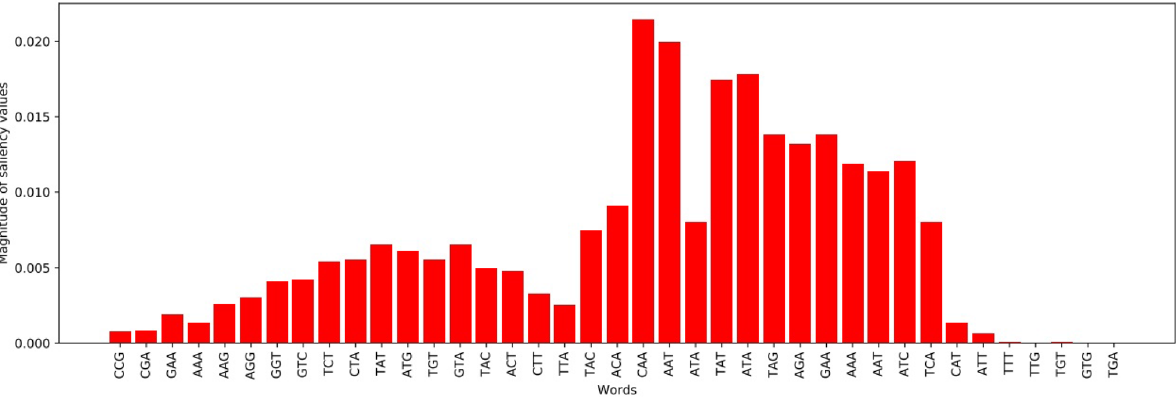
Figure 4. Illustration of saliency map of each 3-mer words having significant importance on the model